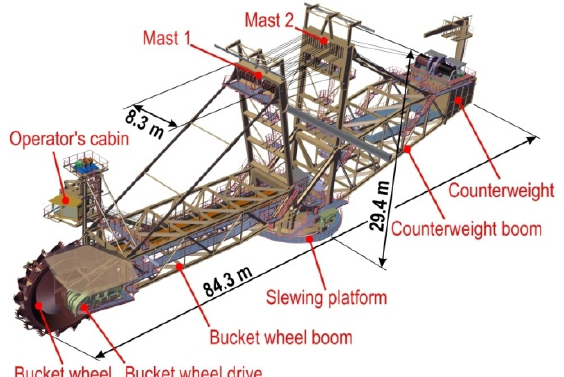
Figure 1. BWE SchRs 1600: Three-dimensional model of the slewing superstructure (total mass: 1172 t).